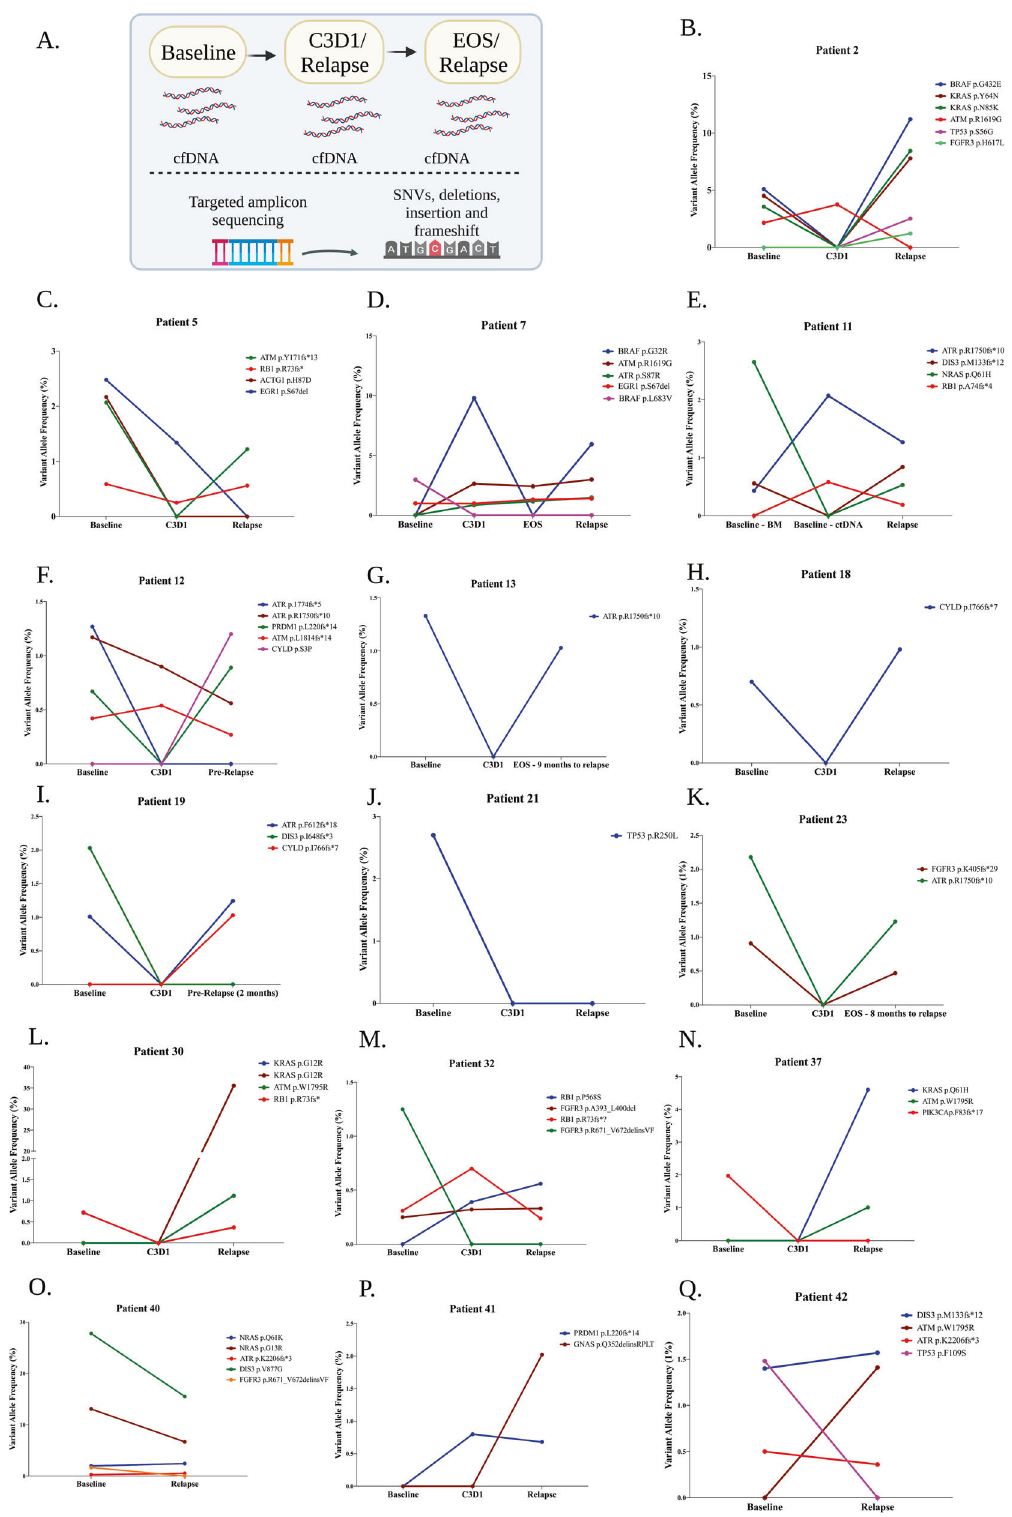
Fig. 2 The dominant mutations at relapse are already present at the start of therapy. A Schematic of the analysis performed to assess the kinetics of ctDNA during treatment and subsequent relapse. B – Q Sequential ctDNA TAS analysis of 16 patients that relapsed with the VAF of the mutations present at each of the time points shown in the line graph. In 87.5% of the patients, at least one mutation at relapse/pre-relapse was already present at the start of therapy. cfDNA cell-free DNA, ctDNA circulating tumour DNA, BM bone marrow, C3D1 cycle 3 day 1, EOS end of study, VAF variant allele frequency, TAS targeted amplicon sequencing. Figures were generated using